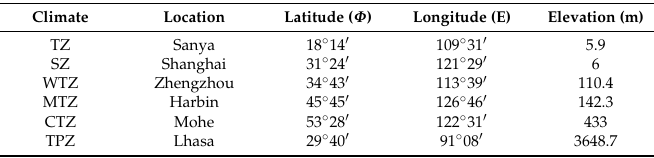
Figure 1. General layout of the six major climates across China. TZ = tropical zone; SZ = subtropical zone; WTZ = warm temperate zone; MTZ = mid temperate zone; CTZ = cold temperate zone; TPZ = Tibetan plateau zone. Table 1. General information about selected six typical stations.